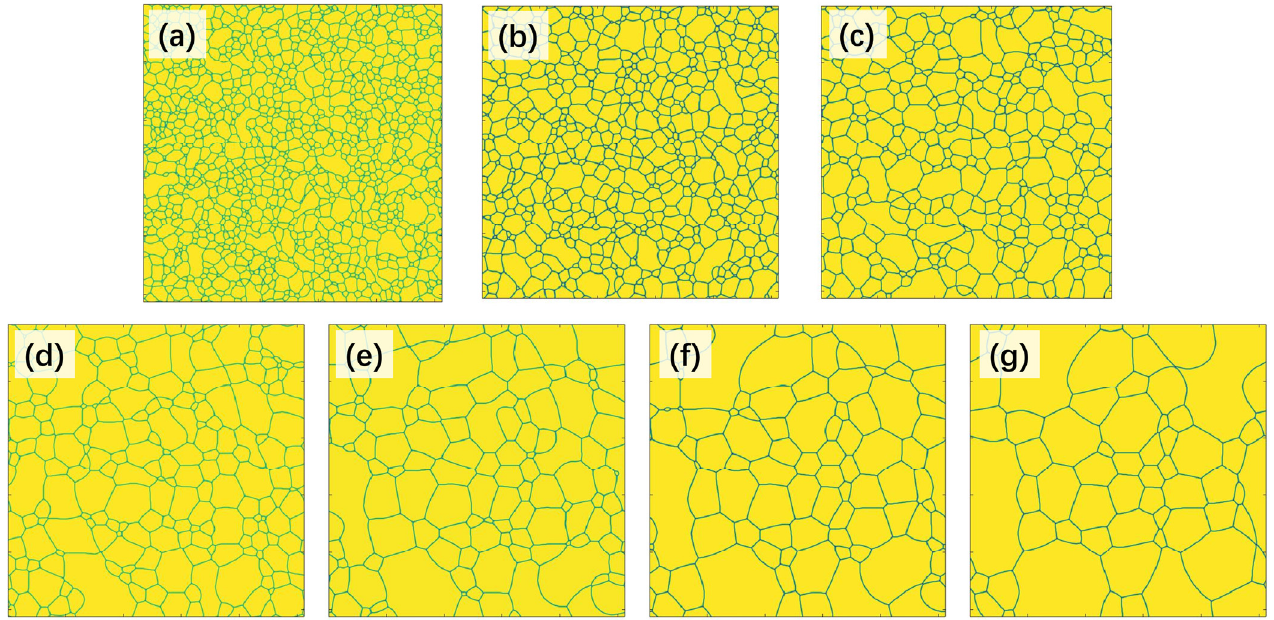
Figure 3. The evolution of grain structures during the heating process. ( a – g ) Simulated grain structures at 1050, 1075, 1100, 1125, 1150, 1175, and 1200 °C, respectively.